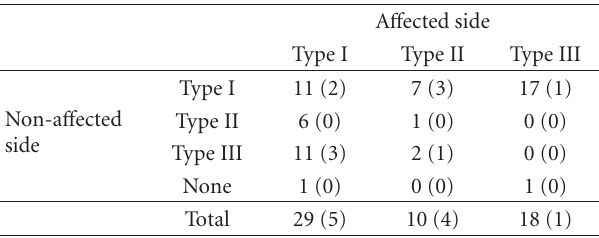
Table 3: Data for dominant sides in the three types of the vertebral artery with comparison of a ff ected and nona ff ected